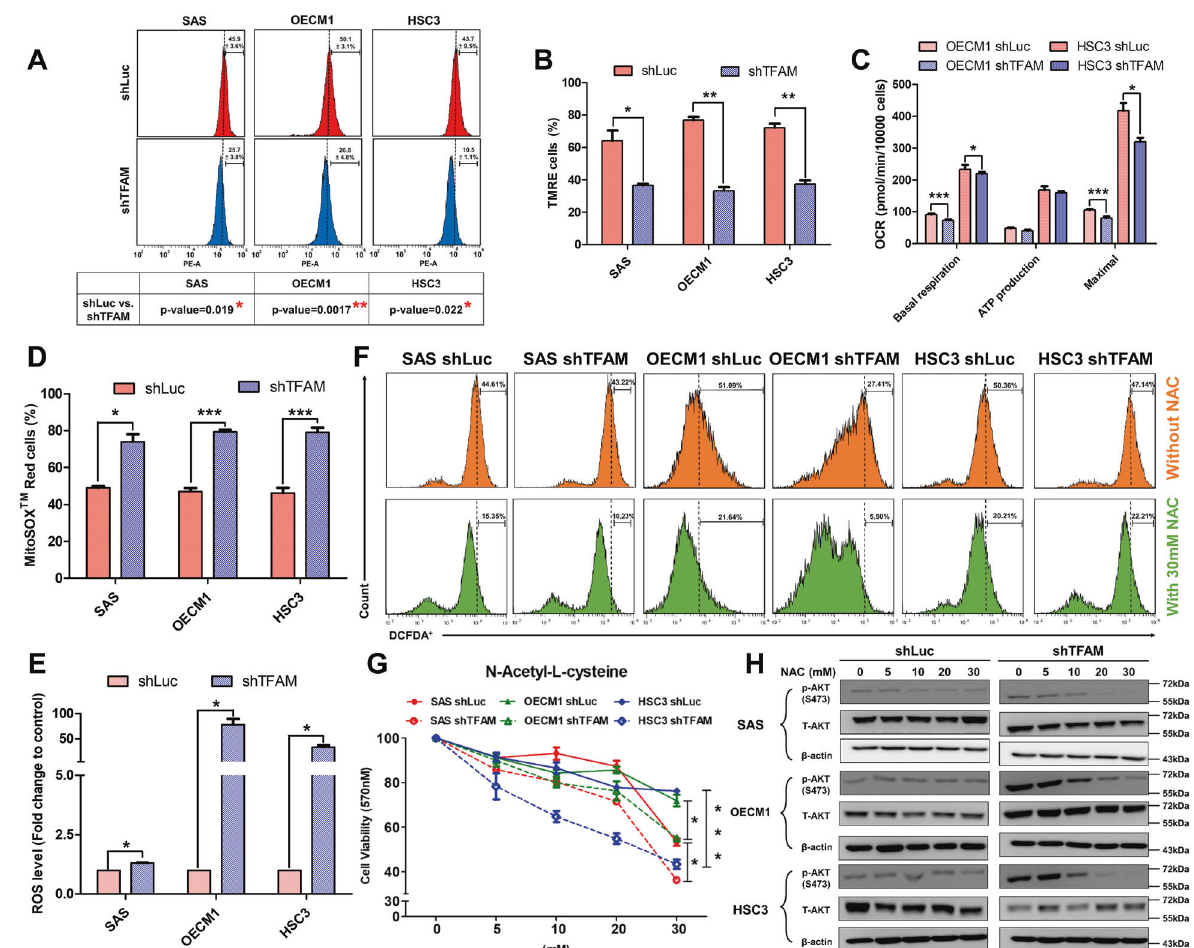
Fig. 5 TFAM loss affects mitochondrial physiology in HNC cells. A Flow cytometrical analysis showed that TFAM loss led to decreased mitochondrial activity by Mitotracker Red staining in HNC cells. B Flow cytometrical analysis showed that TFAM loss led to decreased mitochondrial membrane potential by using TMRE staining in HNC cells. C Seahorse analysis indicated a drop of basal respiration, maximal respiration and ATP production in TFAM-silenced HNC cells. A signi fi cant increased cellular and mitochondrial-derived ROS content was detected using ( D ) MitoSOX staining and ( E ) a fl ow cytometry based DCFDA assay in TFAM-silenced HNC cells compared with their control counterparts. F ROS content was detected by fl ow cytometry in SAS, OECM1 and HSC3 cells with 30 mM NAC treatment. G MTT assay showed a greater drop of cell viability in TFAM-silenced HNC cells compared with control cells in response to NAC treatment. Cell viability of control and TFAM-silenced HNC cells treated with 30 mM NAC was statistically analysed. H Western blot analysis for total and phosphorylated Akt in SAS, OECM1 and HSC3 cells treated with different NAC concentrations. Data are presented as Mean ± SEM ( N = 3 independent biological replicates). * p < 0.05, ** p < 0.01, *** p <